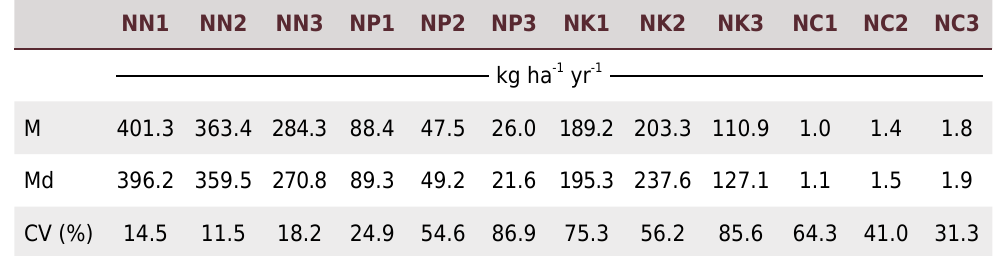
M: mean; Md: median; CV: coefficient of variation. NNi: need for nitrogen (in years 1, 2 and 3); NPi: need for P (in years 1, 2 and 3); NKi: need for K (in years 1, 2 and 3); NCi: need for liming (in years 1, 2 and